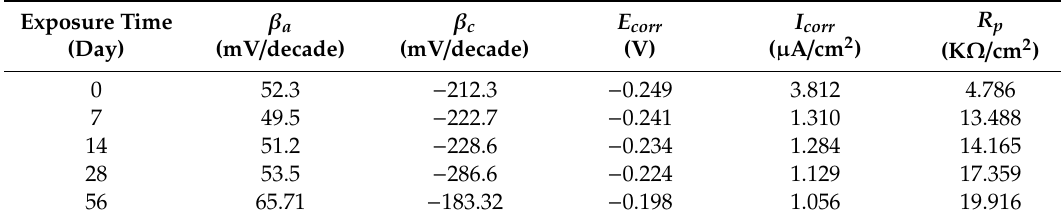
Table 5. Characteristic parameters obtained from the polarization curves of the two alloys after being exposed in corrosion solution for di ff erent